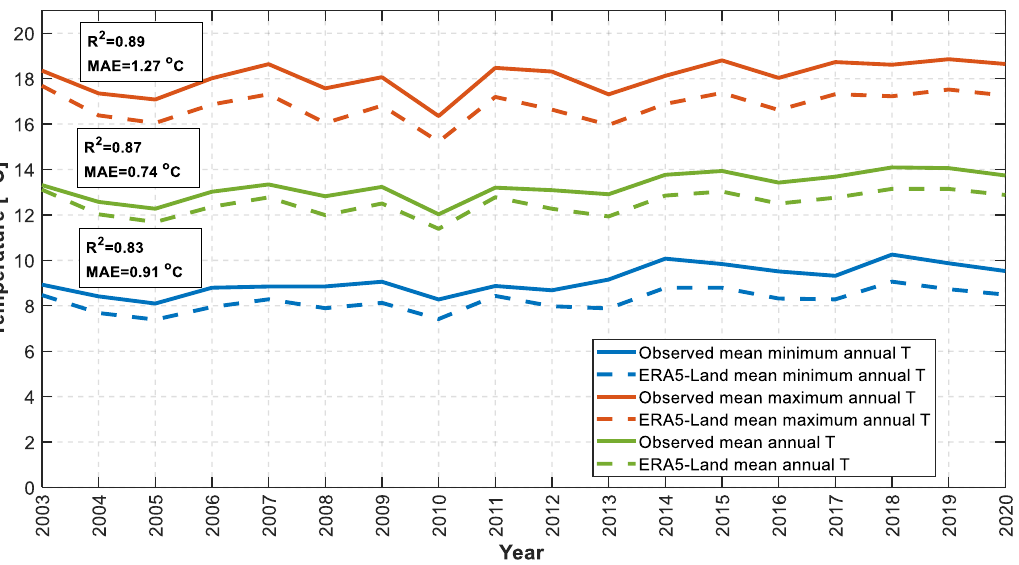
Figure 5. Comparison between ERA5-Land and observed minimum, mean, and maximum annual temperature data (Meteonetwork and ARPA weather stations).